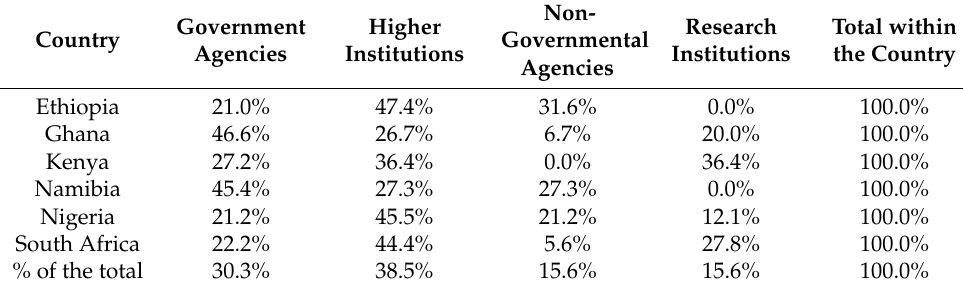
Table 3. Respondents’ workplaces.